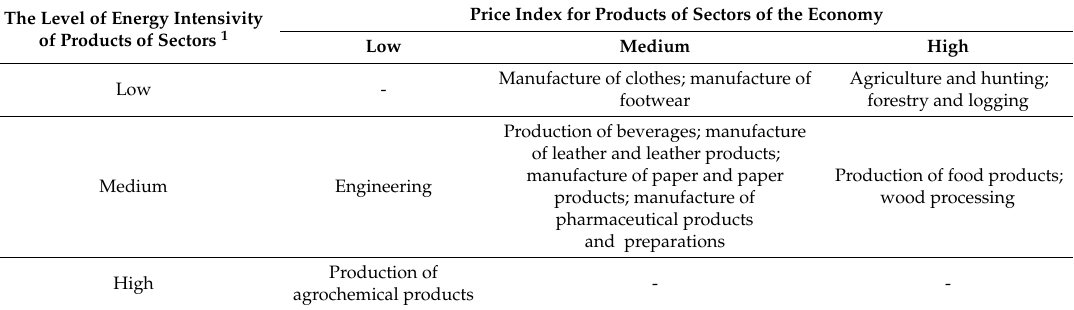
Table 4. The division of sectors of the economy of Ukraine in terms of energy intensity of products and the price index for